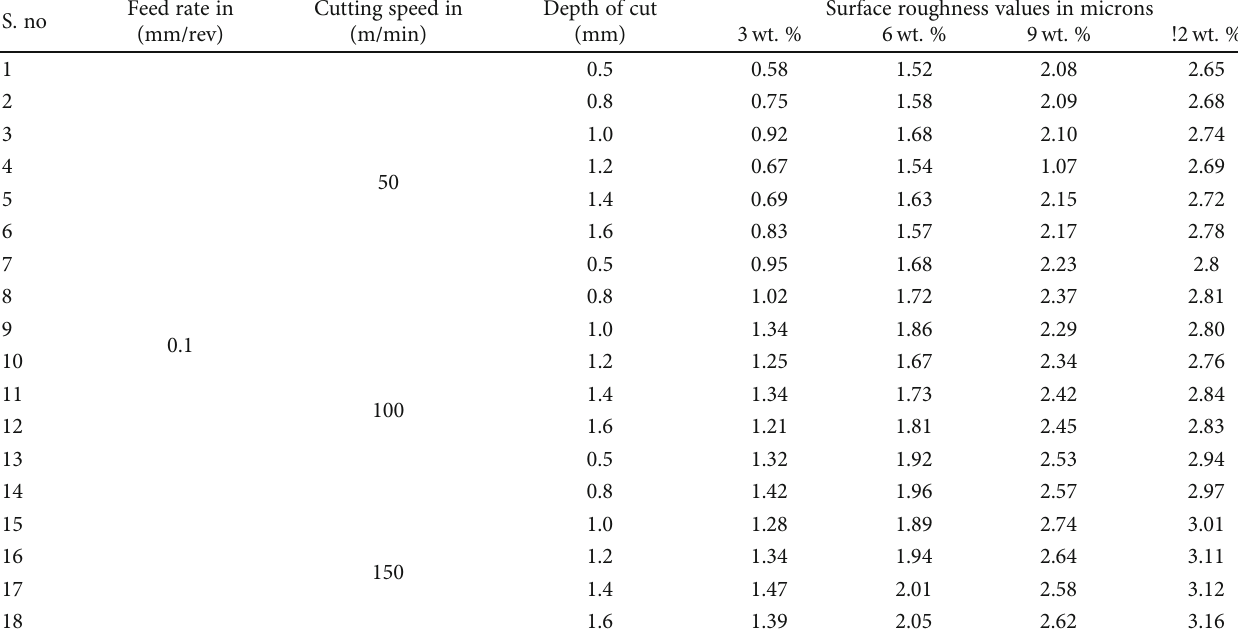
Table 5: Cutting force summary (cutting speed